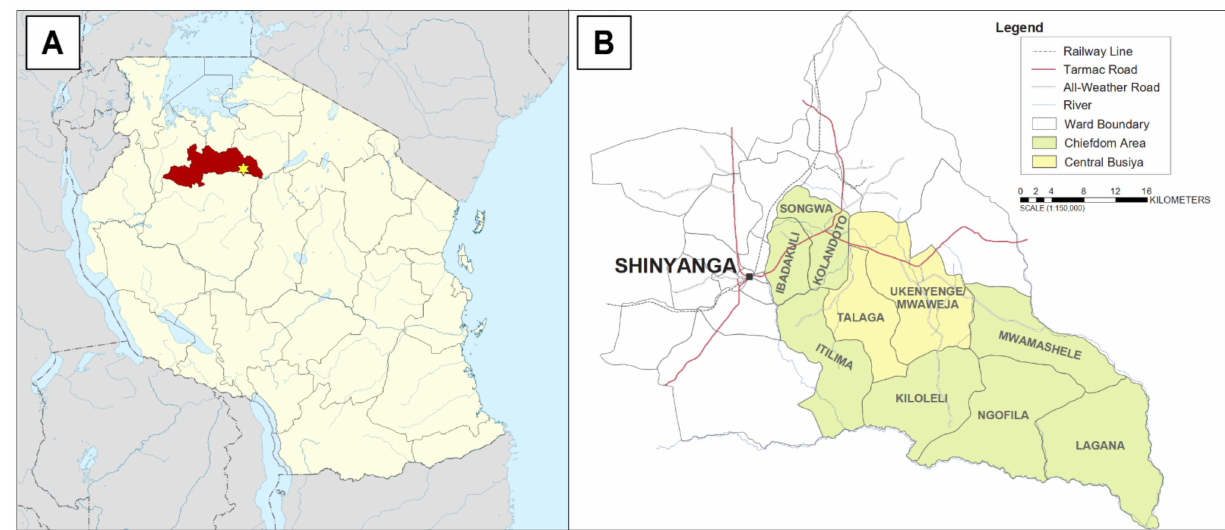
Figure 1. Study location. ( A ) Location of the Busiya chiefdom (star) within the eastern Shinyanga region (red) in northwestern Tanzania; ( B ) detailed map of wards included in the Busiya chiefdom, with central Busiya highlighted in yellow. Tanzania political map courtesy of Wikimedia